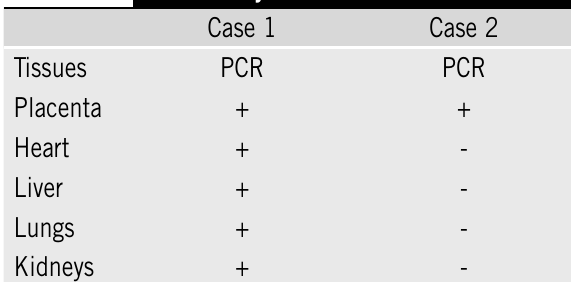
Results of the investigation for PB19 infection by PCR in the various tissues Case 1 Case 2